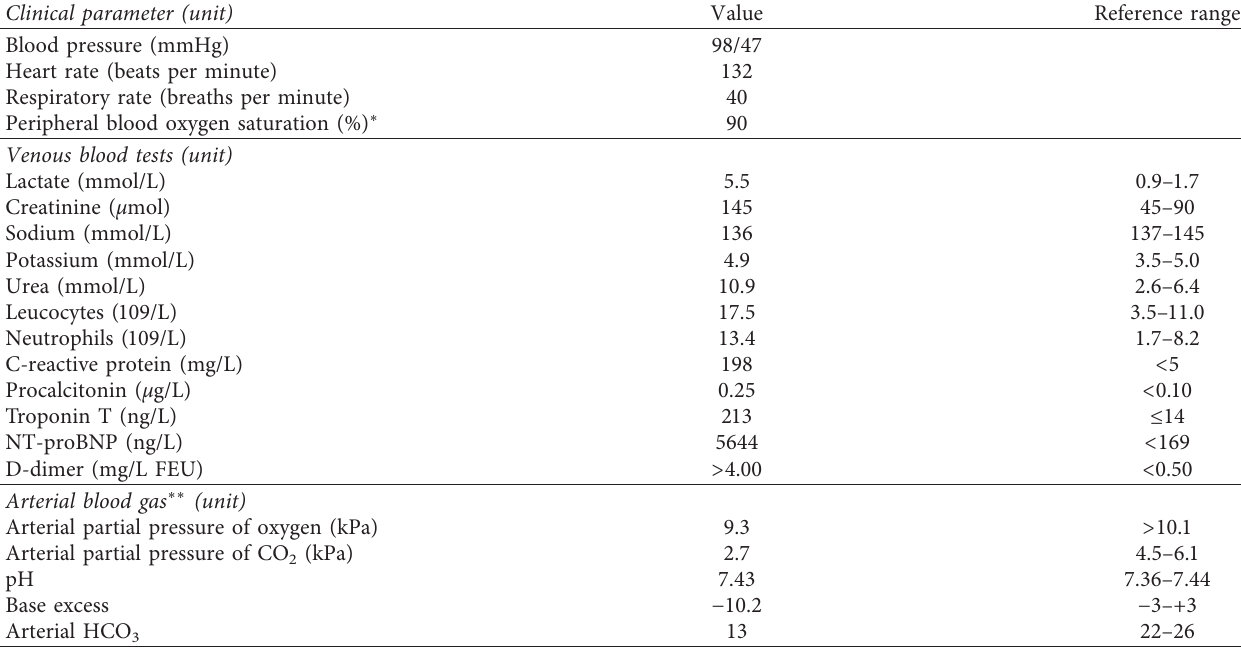
Table 1: Clinical parameters and biochemical findings at